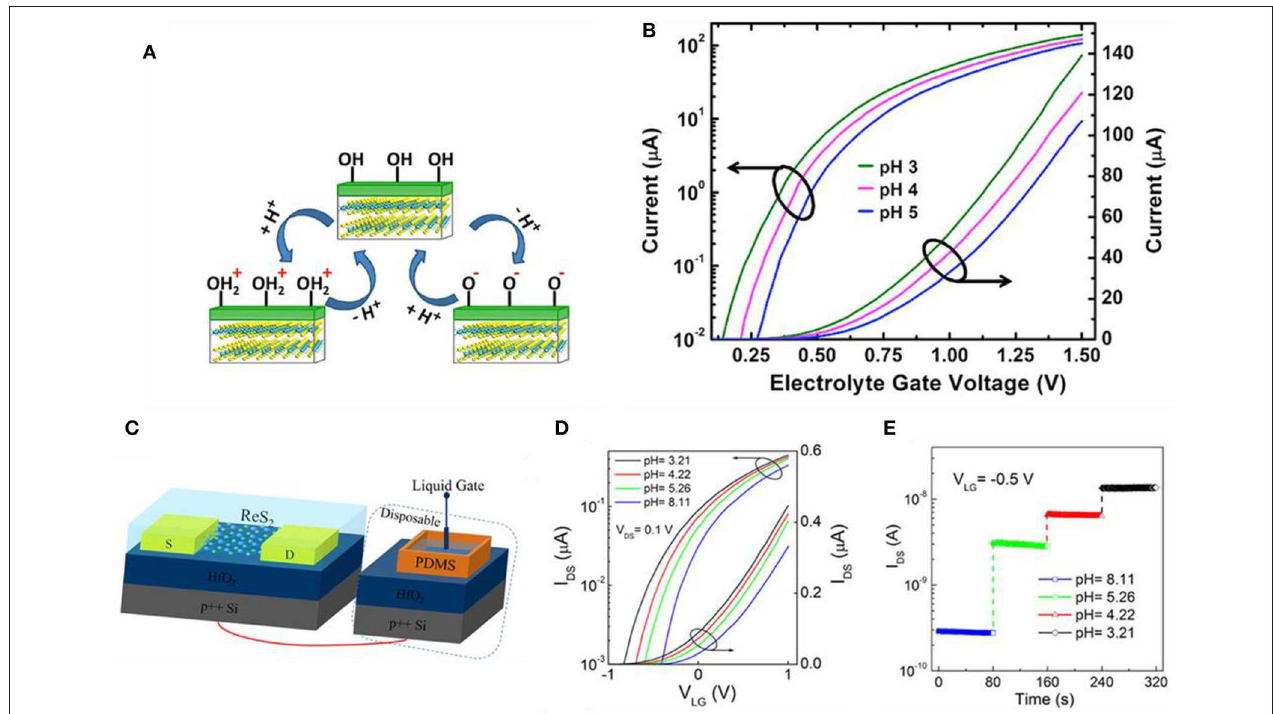
FIGURE 4 | MoS 2 FET and ReS 2 FET pH sensors. (A) Sensing mechanism of MoS 2 pH sensors. At low pH, OH + 2 forms by protonation of OH on the dielectric surface, consequently forming a positive surface charge on the dielectric. At high pH, O − forms by deprotonation of OH on the dielectric surface, consequently forming a negative surface charge on the dielectric. (B) Drain current vs. electrolyte gate voltage in various pH values for an n-type MoS 2 FET. Figures (A,B) were reproduced from Sarkar et al. (2014) with permission from the American Chemical Society. (C) Illustration of ReS 2 FET for pH sensing. (D) Transfer curves ( I DS - V LG ) at various pH values. (E) Response curves at different pH with V DS = 0.1V and V LG = − 0.5V at RT. Figures (C–E) were reproduced from Liao et al. (2018) with permission from the American Chemical